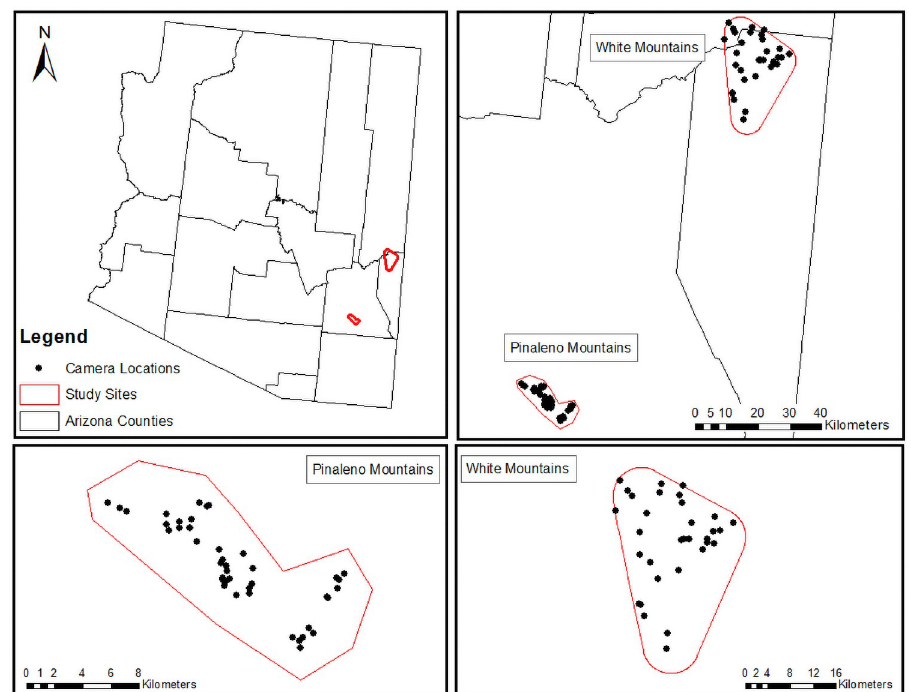
Fig 1. Map of study sites and camera trap array in southeastern